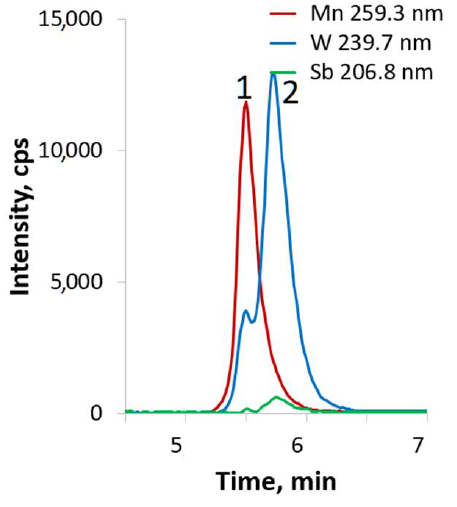
Figure 4. HPLC-ICP-AES chromatogram of 2 in water at natural pH.